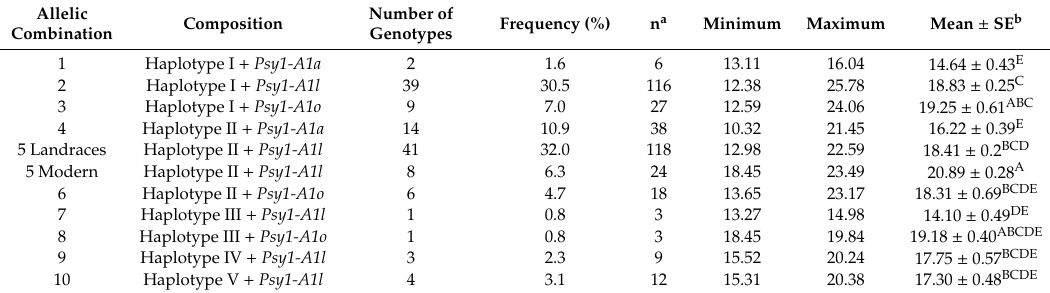
a Data from Table 3, b* values for Pirque 2017, Chill á n 2017, and Chill á n 2018. b Means with di ff erent uppercase letters correspond to significantly di ff erent values after one-way ANOVA and Tukey’s post hoc test ( p <